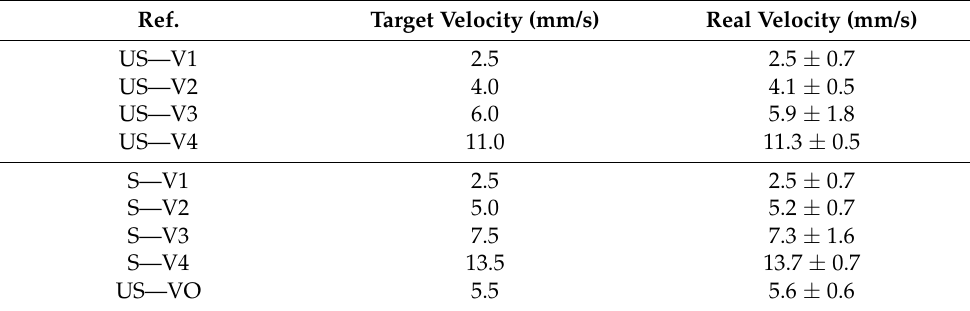
Table 2. Target and real impregnation velocities for the manufactured specimens.